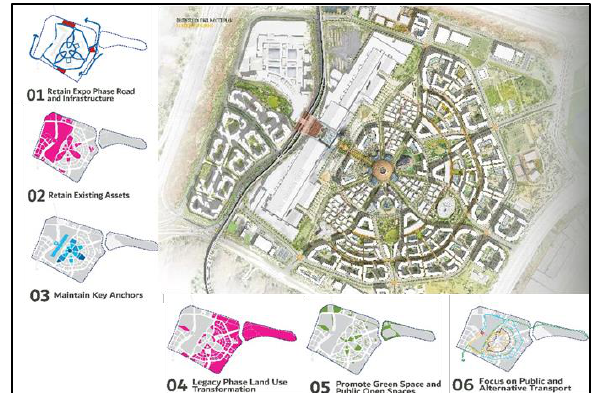
Figure 3 . Main Factors of Sustainability Strategy of Dubai